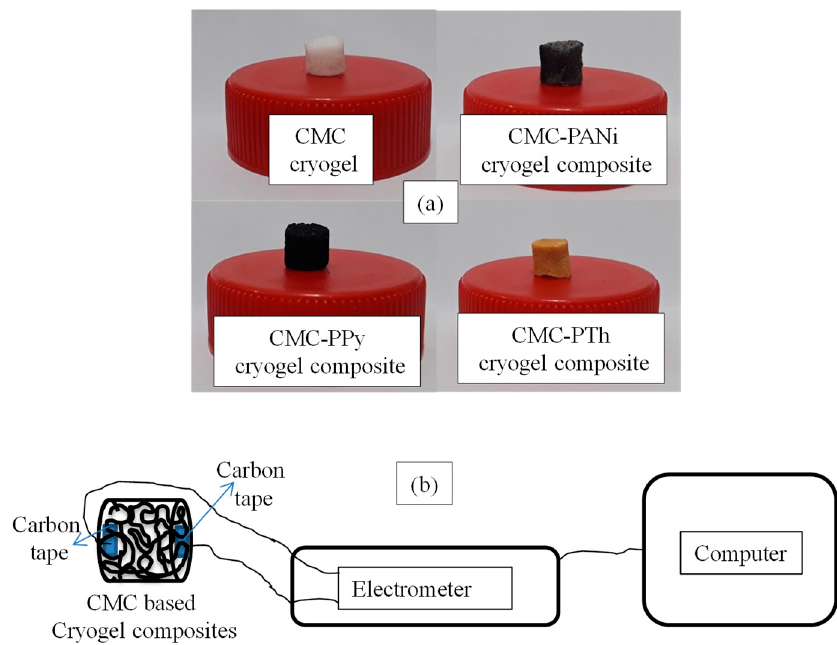
Figure 3. ( a ) Digital camera images of synthesized CMC cryogel, CMC–PANi, CMC–PPy, and CMC–PTh cryogel composites; and ( b ) schematic representation of electrometer measurement.